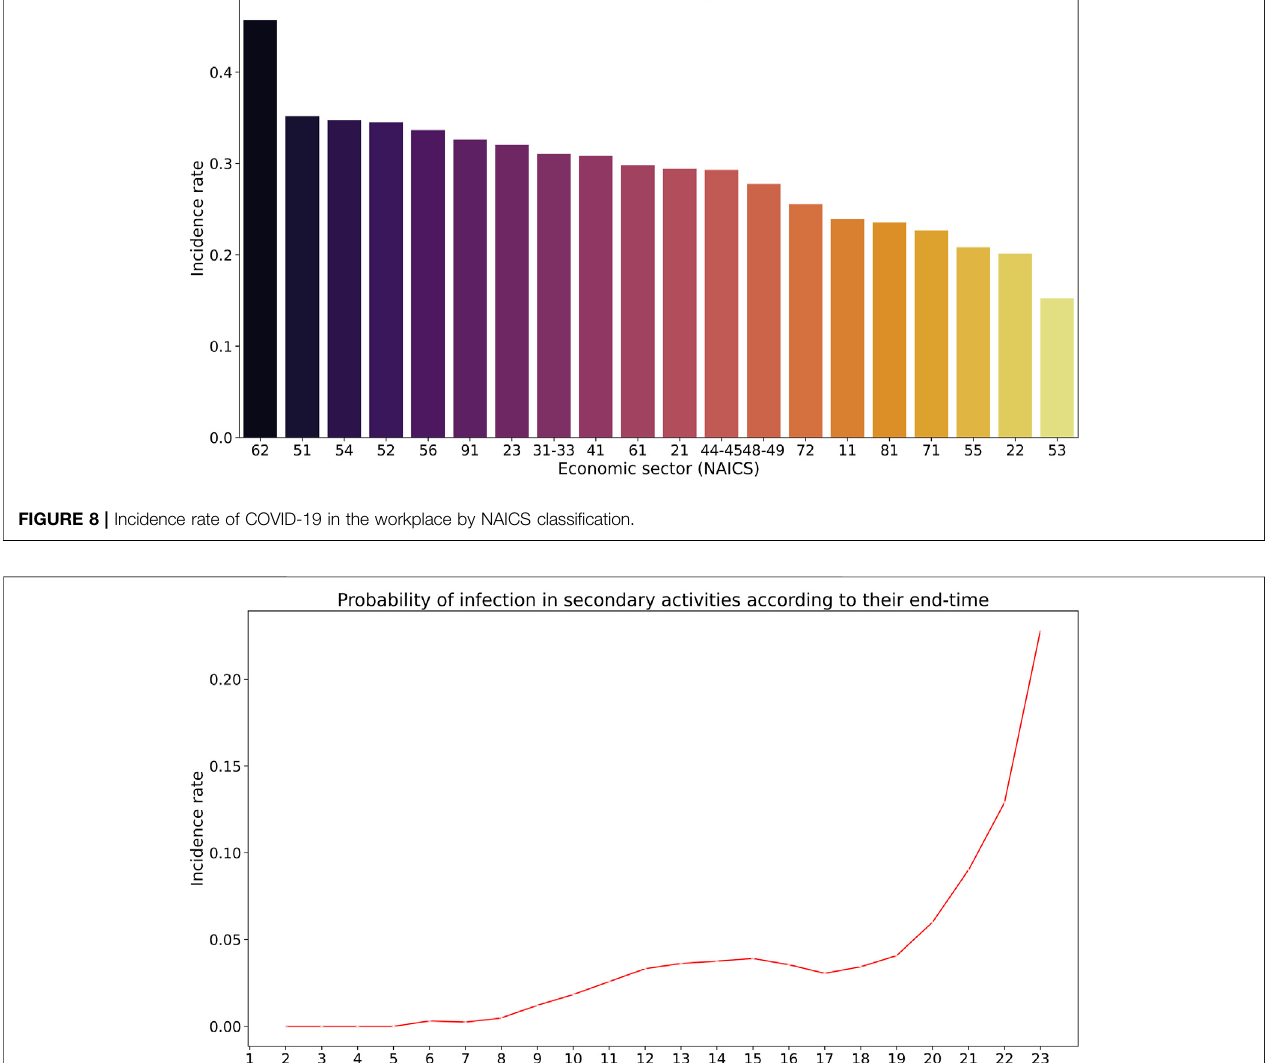
Frontiers in Built Environment |